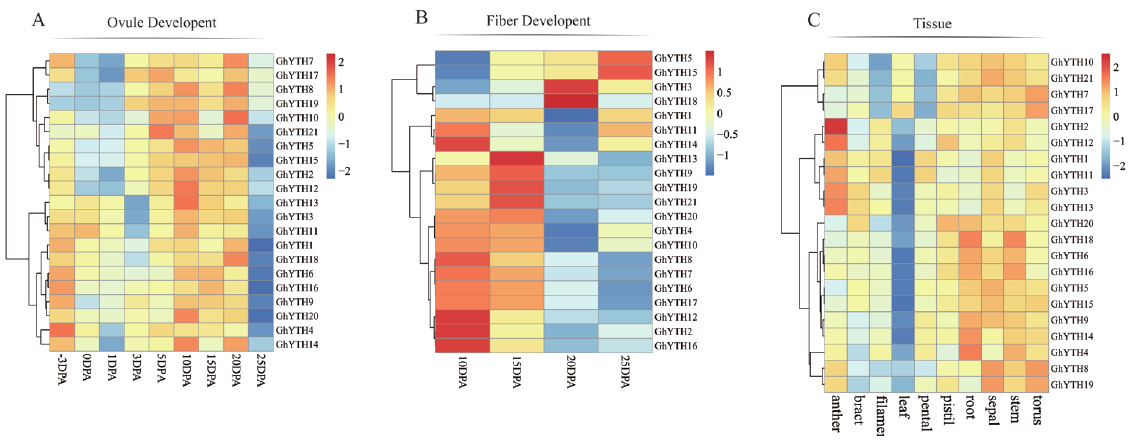
Figure 7. Expression patterns of GhYTH genes in different tissues. ( A ) Expression patterns of GhYTHs